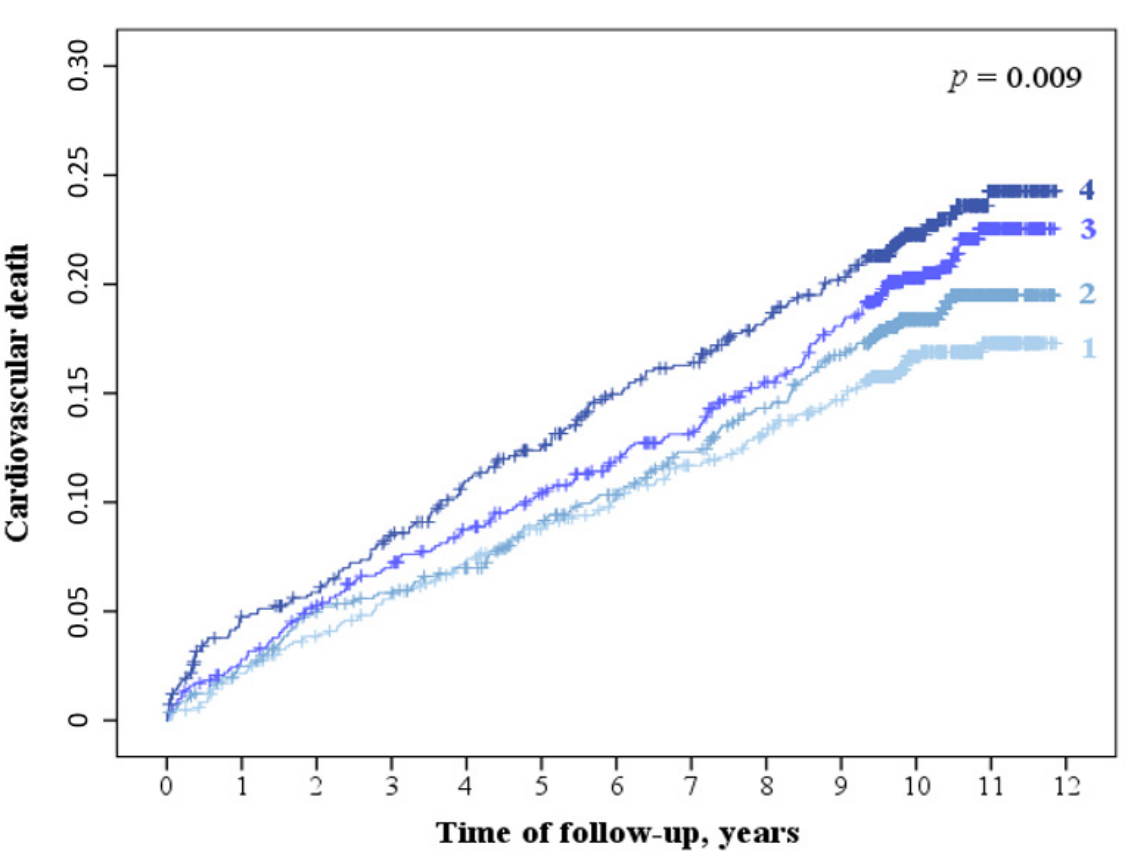
Figure 2. Kaplan-Meier curves for cardiovascular death according to LDLapoB/LDLC meas quartiles in the entire LURIC cohort. Legend: 1-4: LDLapoB/LDLC meas quartiles; p calculated with log-rank test Table 2. Cardiovascular mortality according to LDLapoB/LDLC meas quartiles in the LURIC cohort.